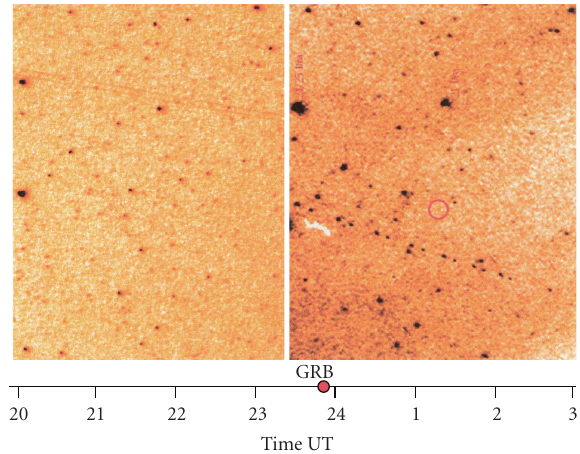
Figure 7: The area of the GRB000926 on the photographic plates of the EN network. Left: preburst image (end of exposure 29 minutes before the GRB trigger), lim magnitude 10. Right: simultaneous image, lim magnitude 8. The position of the GRB is indicated by a circle. Both images contain airplane